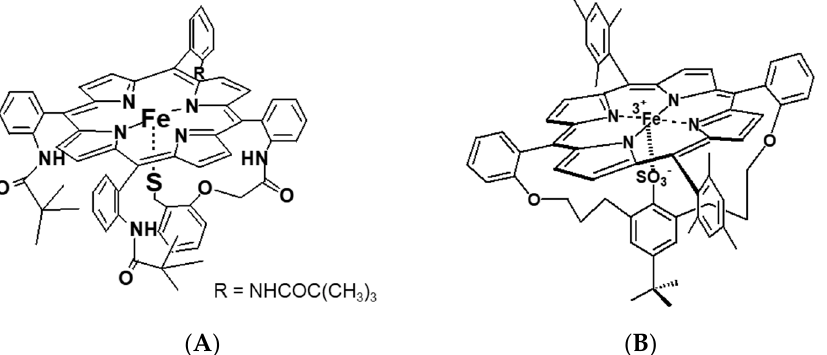
Figure 12. ( A ) Synthetic heme–thiolate complex, SR complex, ( B ) model of P450 bearing R-SO 3 − as an axial ligand (R-SO 3 − ). Reprinted with permission from Journal of the American Chemical